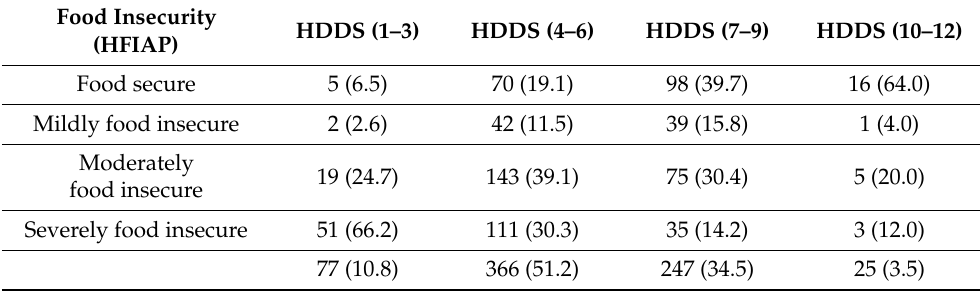
Table 6. Relationship between migrant household food security and dietary